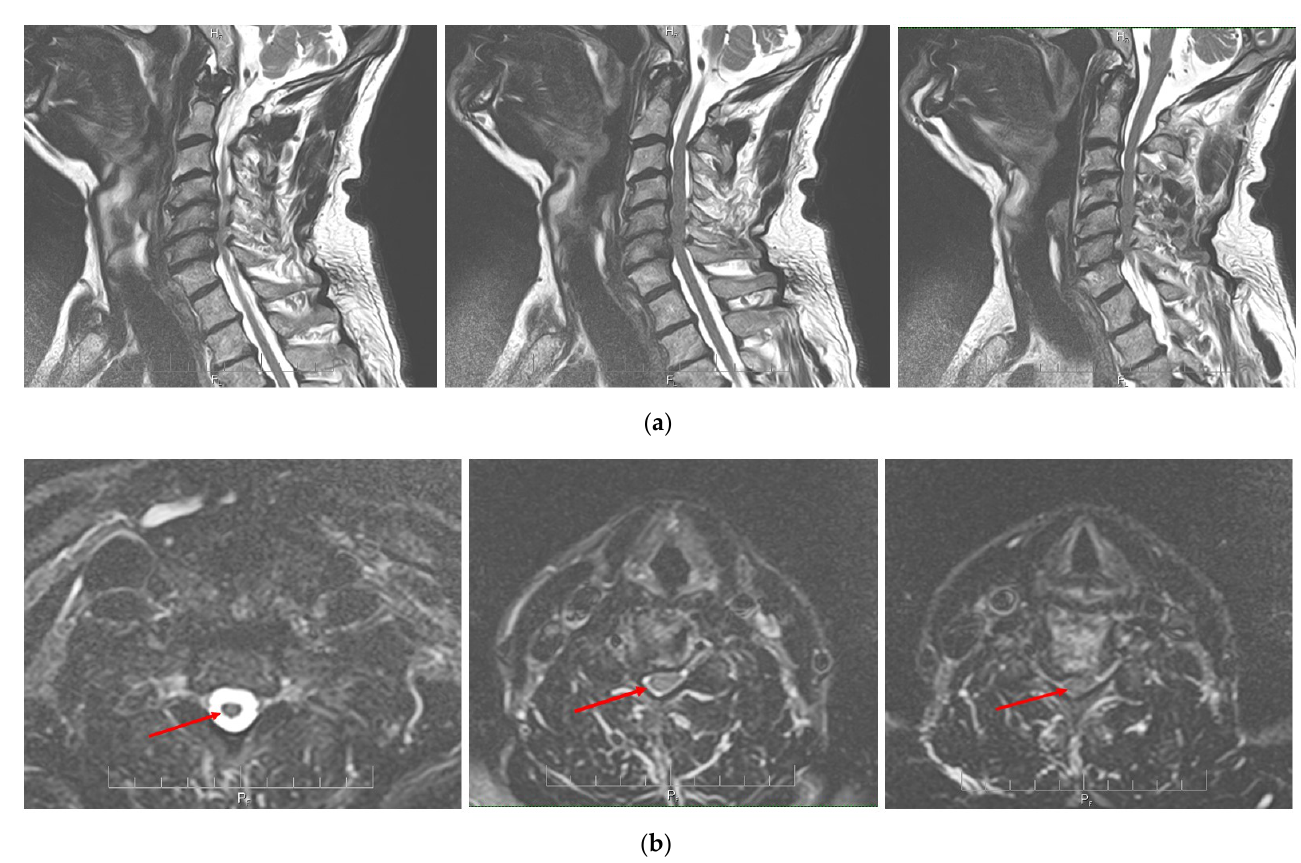
Figure 12. Sequential T2-weighted MRI sagittal scans ( a ) and axial scans ( b ) of the cervical spine demonstrate compression of the spinal cord (red arrow) via spondylotic changes and herniated discs at the level of C3 – C7 in a 65-year-old patient with cervical myelopathy. On differential diagnosis, cervical myelopathy was excluded due to the absence of impairment of the UMN in the lower extremities. Cervical spondylotic amyotrophy was excluded because of the absence of radicular compression on cervical spine MRI. Muscu- lar atrophy in clinical cases did not appear similar to oblique amyotrophy associated with Hirayama disease. In addition, normal T2-weighted signals of the spinal cord on MRI at the site of the maximum forward shift in the cervical level led to the exclusion of Hirayama disease.